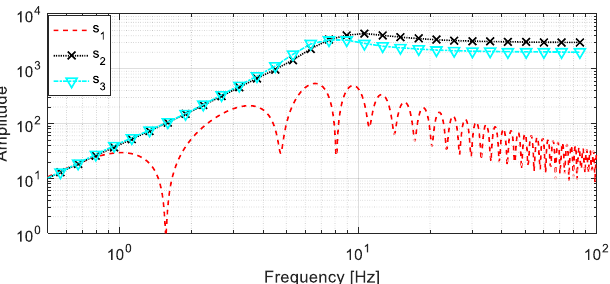
Figure 6. Amplitudes of the acceleration frequency responses of the vehicle at the measurement points to the excitation applied successively on the rear wheel along DOF u 3 and the front wheel along DOF u 4 .